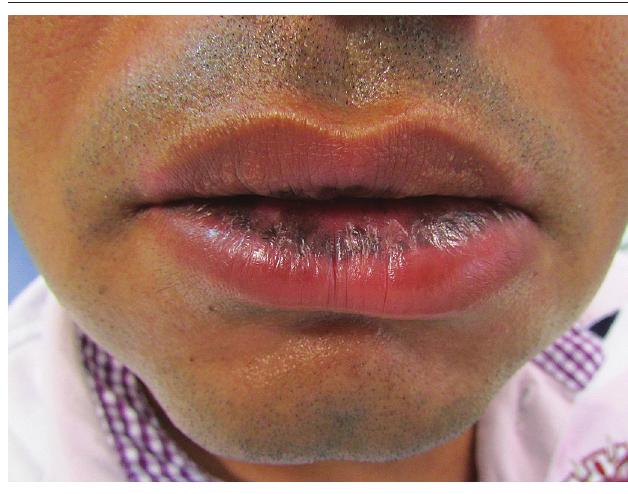
figurE 1 − Brownish macules, of ill-defined borders, in lower and upper lip